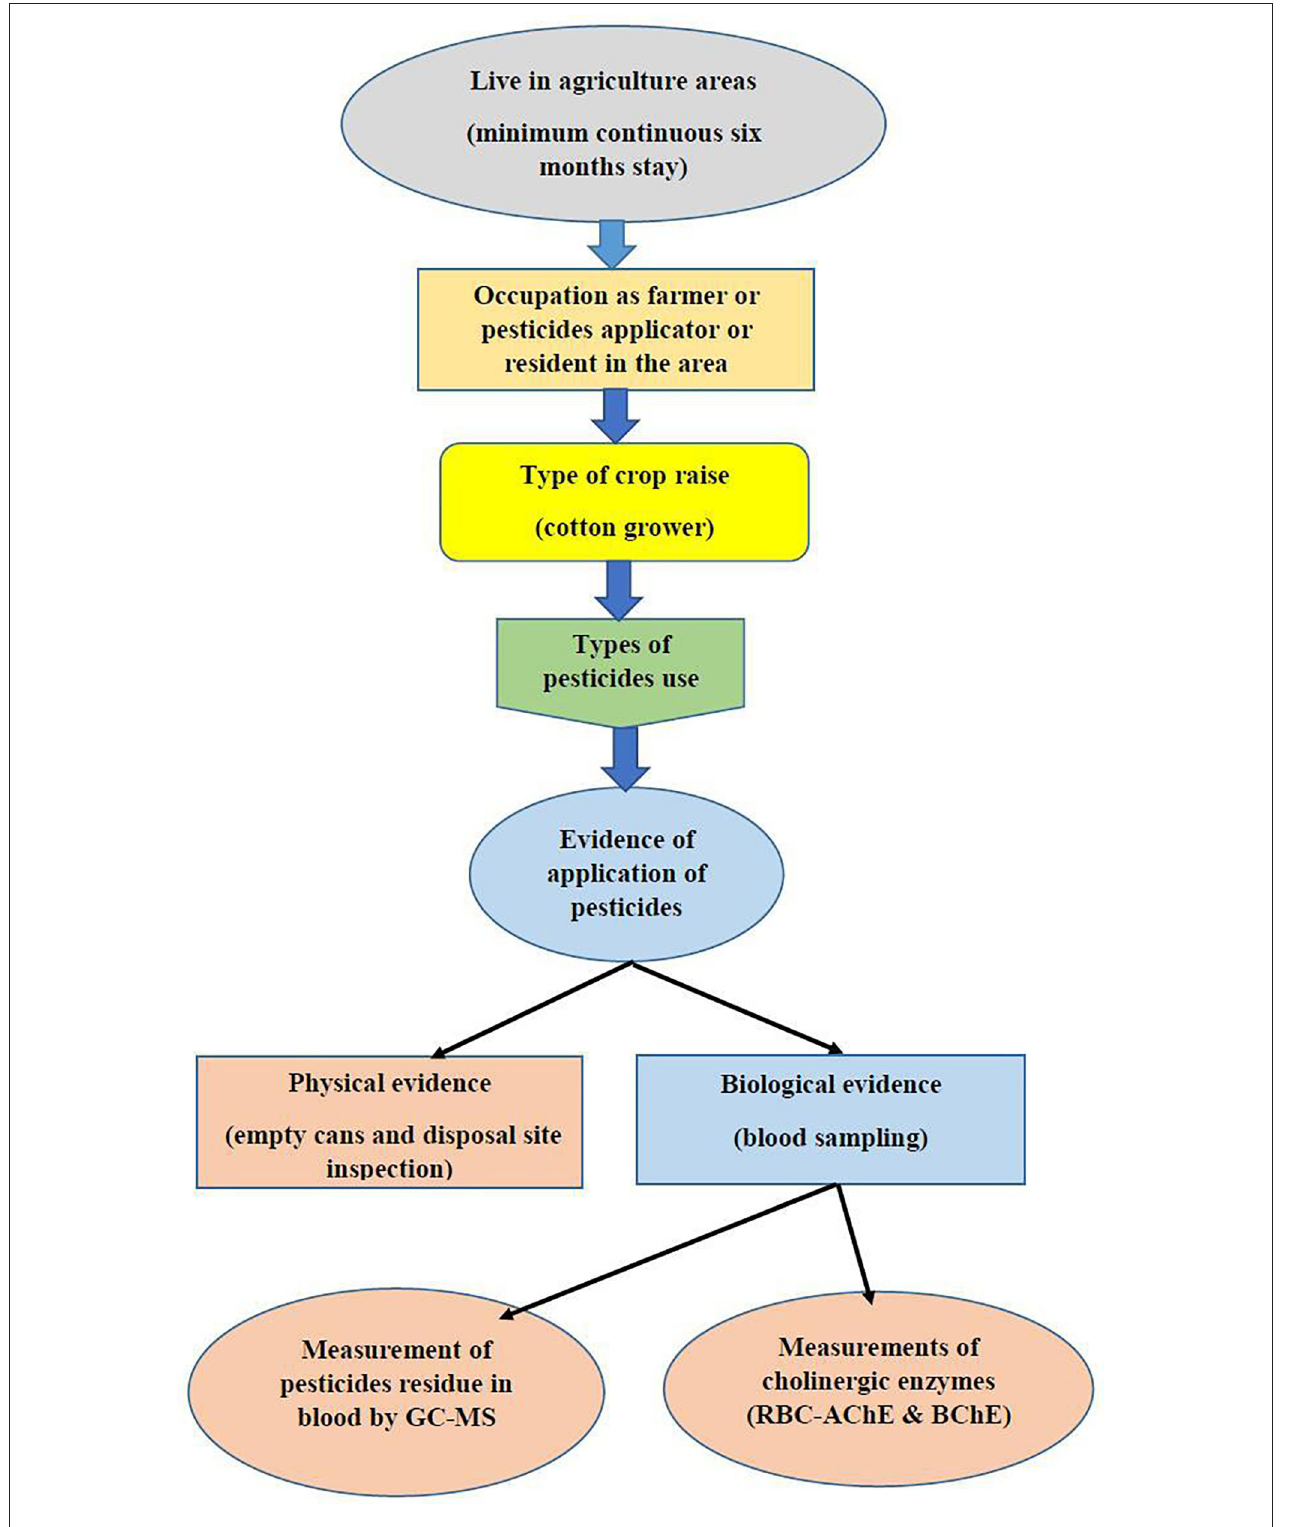
FIGURE 1 | Steps to assess pesticide exposure in the study groups.